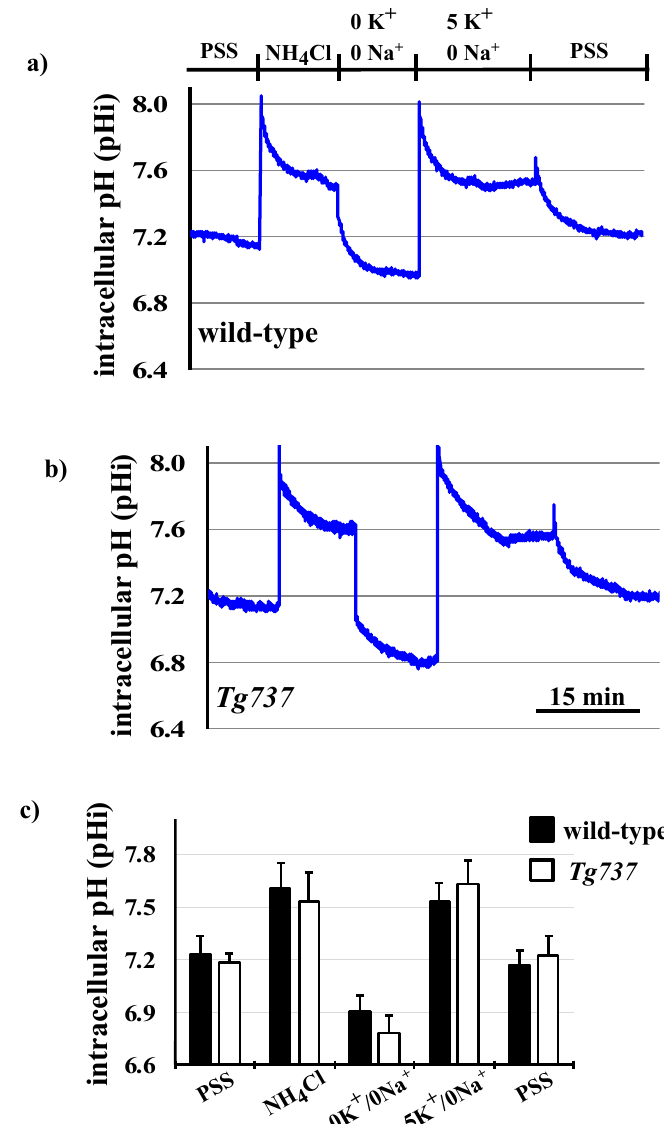
Figure 7. Changes in pH i during the NH 4 Cl pre-pulse in wild-type and Tg737 cells. ( a,b ) Representative tracings of changes in intracellular pH when wild-type and Tg737 cells are exposed to solutions of the NH 4 Cl pre-pulse including the 5 mM K + solution during pH i recovery of wild-type and Tg737 cells. ( c ) Bar graph shows the summary of pH i recovery data from pre-pulse tracings in wild-type and Tg737 cells. N = 5 for wild-type cells and N = 5 for Tg737 cells with the 5K + /0Na + solution.